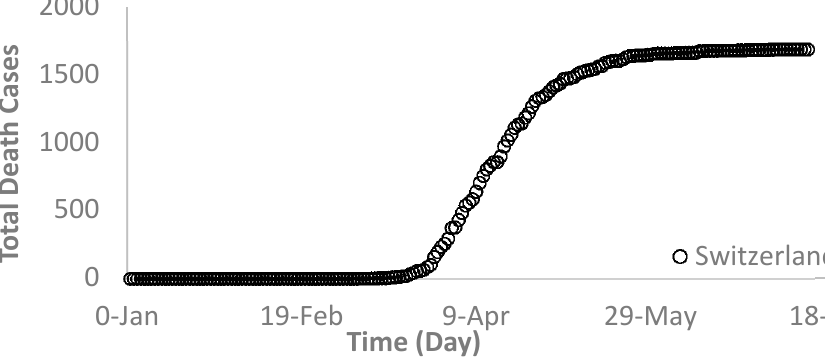
Figure 7. Total deaths due to the novel COVID-19 infections in Switzerland.